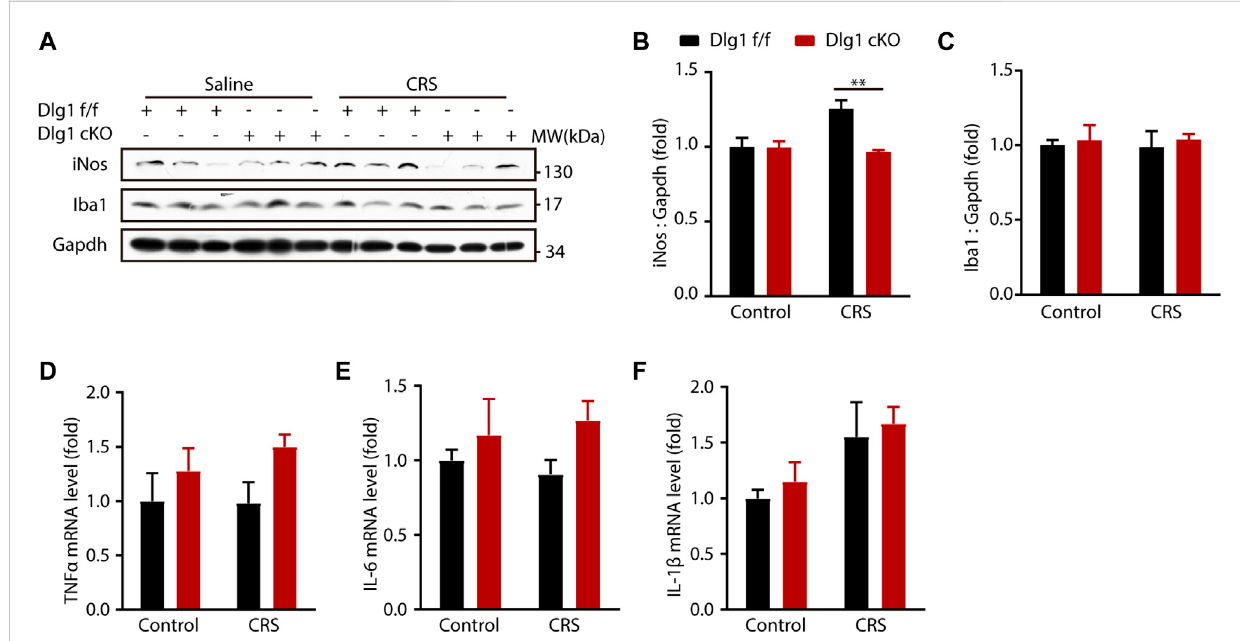
FIGURE 4 Microglial Dlg1 ablation partially decreases in fl ammation state in the mouse brain. (A) Immunoblots of iNOS, Iba1, and Gapdh in the hippocampus tissue of Dlg1 f/f and cKO mice brain slices with and without CRS exposure. (B,C) Quantitative analysis of iNOS and Iba1 protein levels normalized to Gapdh. (D – F) RT-PCR analysis of TNF- α , IL-6 , and IL-1 β mRNA levels in the hippocampus tissues of Dlg1 f/f and cKO mice brain slices with and without CRSexposure.Dataarepresentedasthemean±SEM;* p < 0.05,** p < 0.01,*** p < 0.001,two-wayANOVAwithTurkey ’